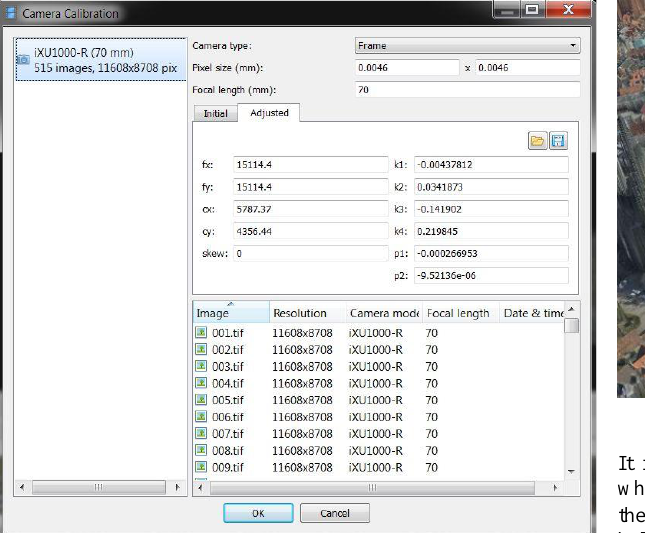
Figure 10. Calibration results for iXU-R 1000